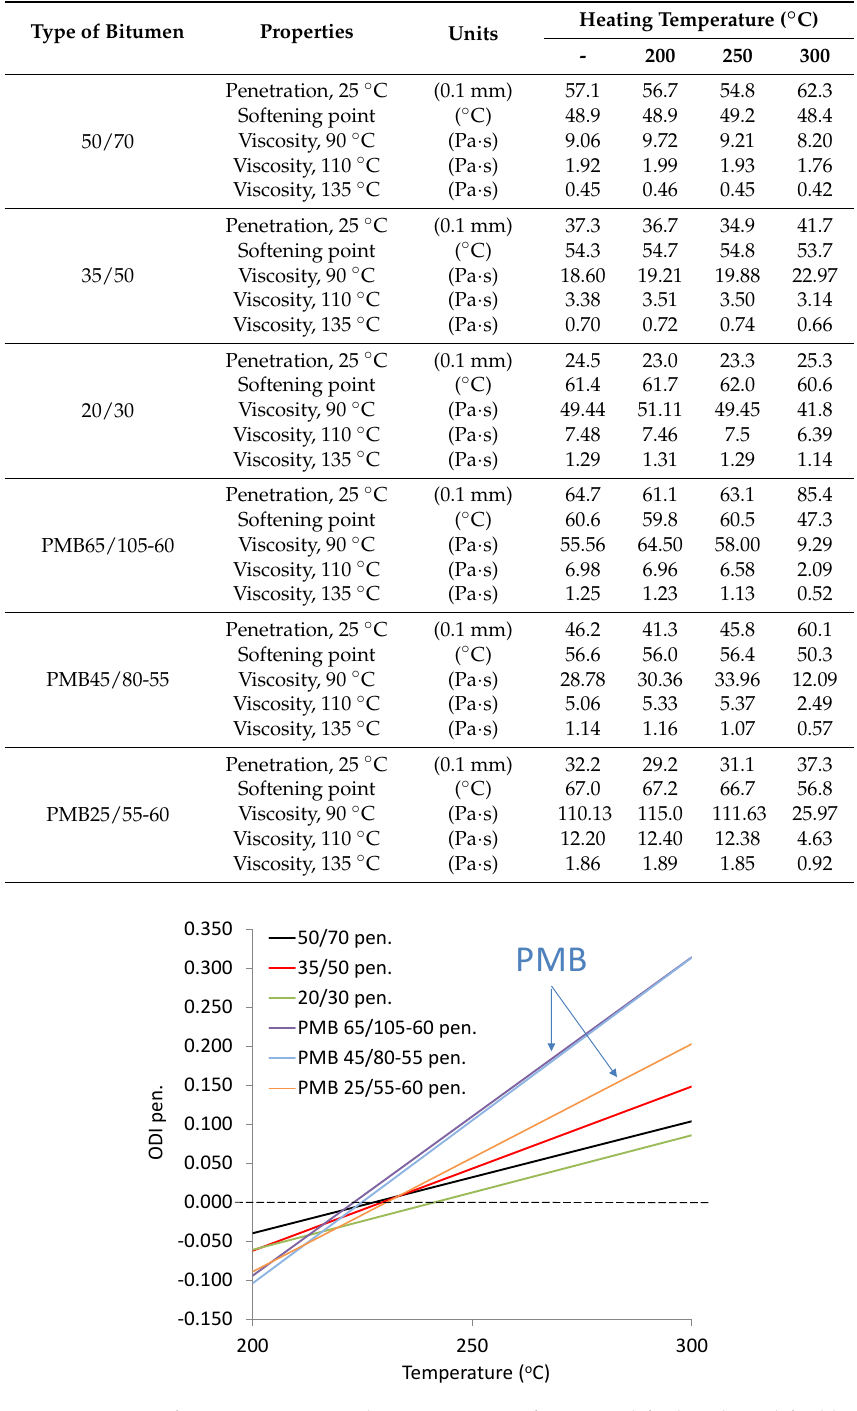
Table 2. The properties of non-modified and SBS polymer-modified bituminous binders before and after heating at a high temperature (1 h).